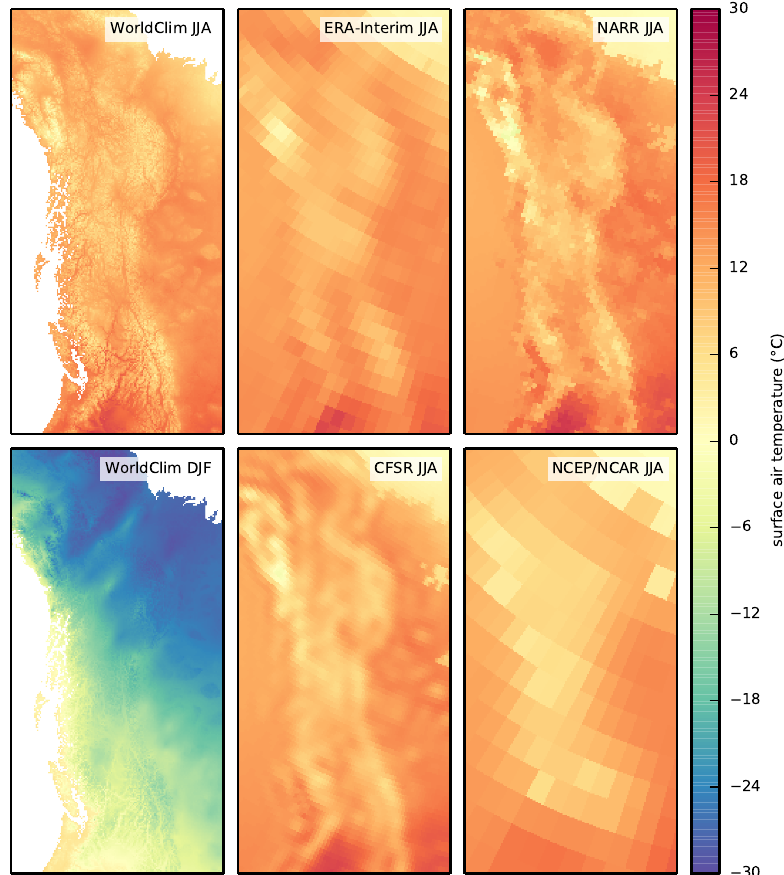
Figure 3. Summer (JJA) and winter (DJF) temperature maps from WorldClim (Hijmans et al., 2005), and summer (JJA) temperature maps from ERA-Interim reanalysis (Dee et al., 2011), North American Regional Reanalysis (NARR; Mesinger et al., 2006), Climate Forecast System Reanalysis (CFSR; Saha et al., 2010), and NCEP/NCAR reanalysis (Kalnay et al., 1996) climatologies. Table 1. Characteristics of reanalysis climatologies used to inform the mass balance component of PISM. Reanalysis Spatial